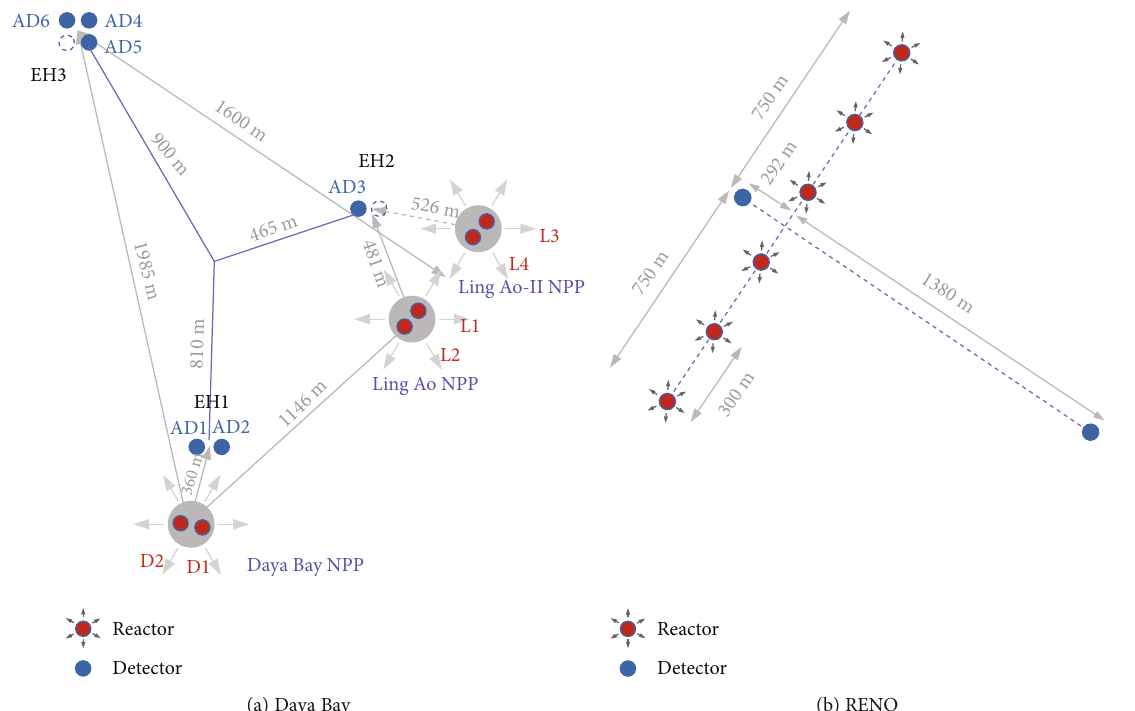
Figure 1: Arrangement of the nuclear reactors, shown as red circles, and antineutrino detectors (ADs), shown as blue circles, for the Daya Bay (6 AD con fi guration) and RENO reactor neutrino experiments. Adapted from [33].